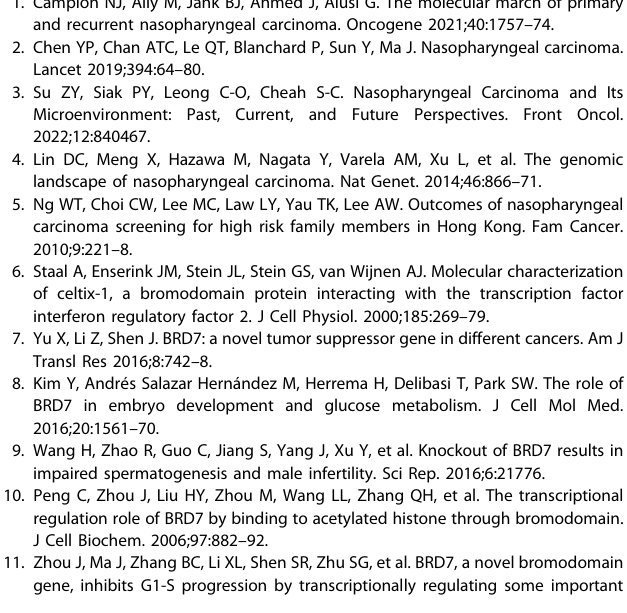
Western blot analysis Cells were harvested and lysed with cell lysis reagent (NCM Biotech, Suzhou, China), and protein was collected. A total of 20 µg of total protein per lane was separated by 4-15% SDS-polyacrylamide gel electrophoresis and was then transferred to 0.2 μ M or 0.45 μ M PVDF membranes (Millipore, Billerica, USA). Subsequently, the membranes were blocked with 5% nonfat milk for 60-120 min. They were incubated separately at 4 °C overnight with the following primary antibodies: anti- BRD7 (Cat# 51009-2-AP, 1:500) and anti- GAPDH (Cat# 60004-1-Ig, 1:10,000) (Proteintech Group, Inc., Wuhan, China); anti- BIRC2 (Cat# 70008, 1:1,000), anti-E-cadherin (Cat# 14472,